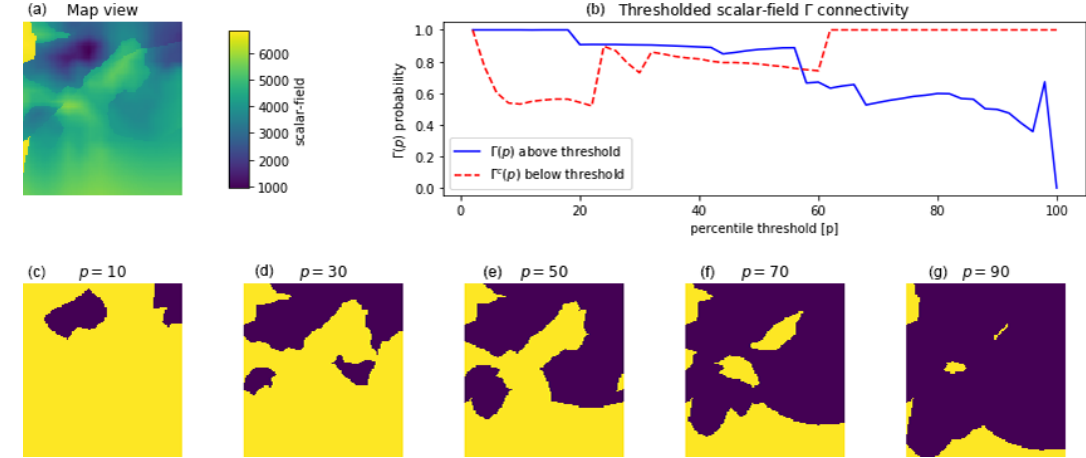
Figure 10. Illustration of a scalar field voxet horizontal section (a) and its global percolation metrics (cid:48)(p) and (cid:48) c (p) (b) computed over the 2D sections; (c–g) display horizontal sections of binary fields obtained by applying different percolation threshold p [ % ] to the scalar field 3D voxet; blue areas, above the percolation threshold, contribute to (cid:48)(p) ; yellow areas, below the percolation threshold, are used to compute (cid:48) c (p)